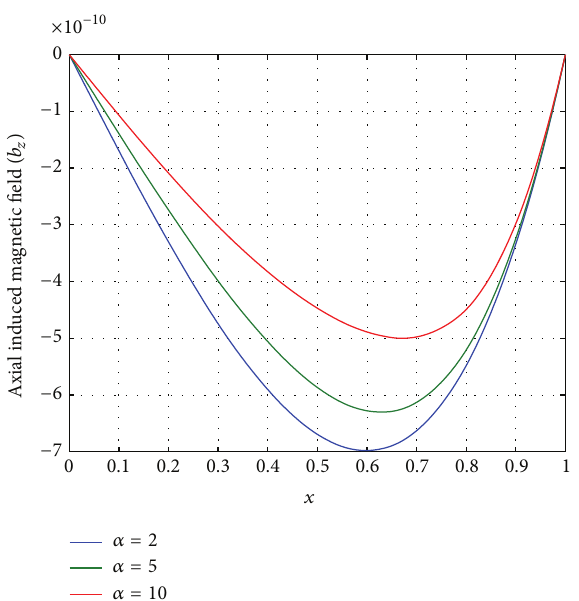
Figure 15: Axial induced magnetic field profiles for different Wom- ersley parameter 𝛼 during its peak value with Re = 100 and Ha = 2 .